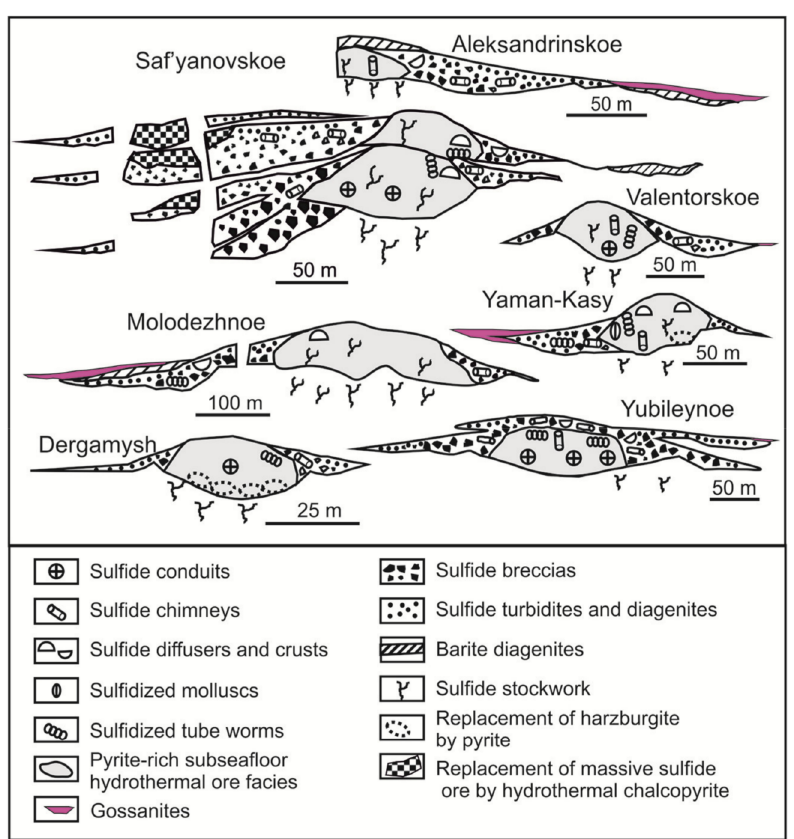
Figure 4. Position of various ore facies, including ore diagenites, in the Urals VHMS